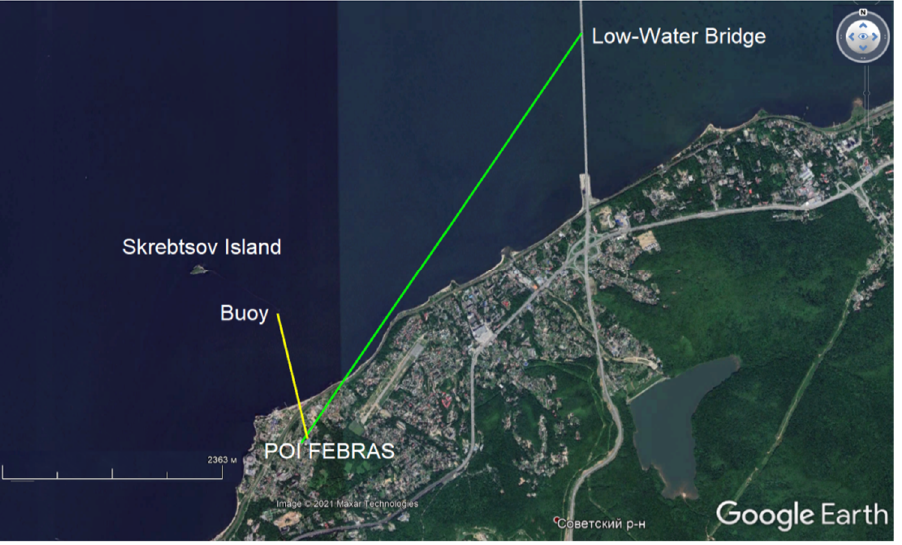
Figure 9. Measurements of waves at long distances in Amurskiy Bay: map of the area. (Google Earth service used).